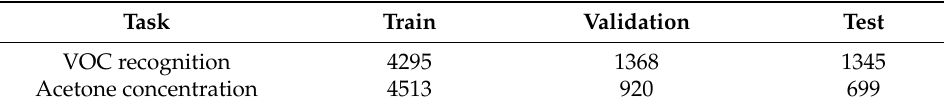
Table 2. Number of droplet sequences in each data set.